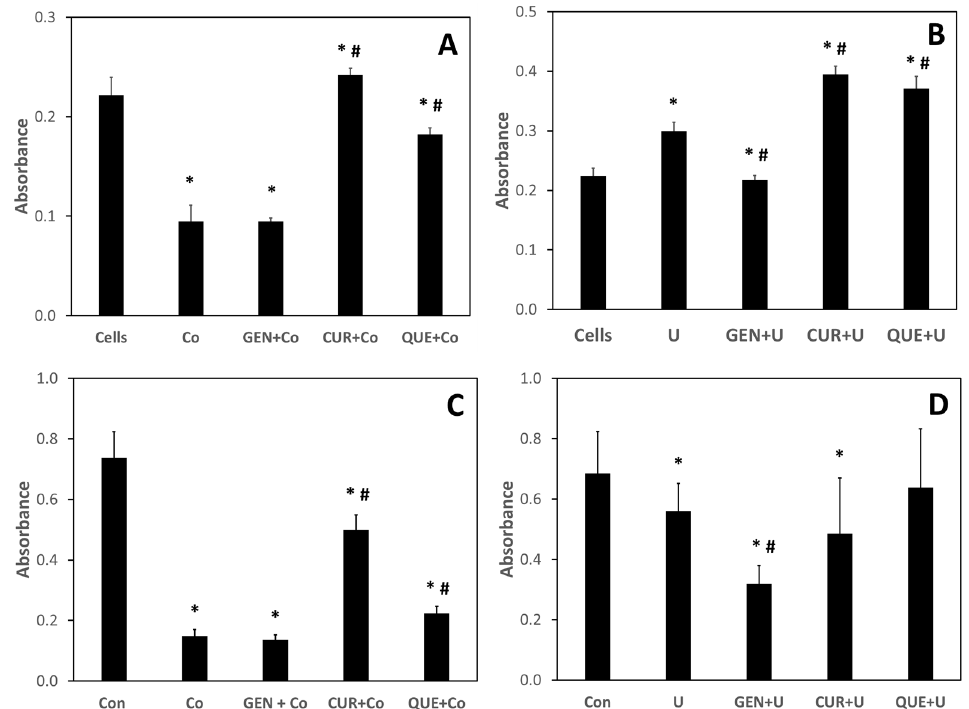
Figure 6. The ability of nutraceutical treatment to rescue cells from metal-induced metabolic toxicity. Effect of nutraceutical exposure on metabolic viability of J774 and Caco-2 cells. Cells were treated with cobalt (Co) or uranium (U) at 100 µM for 1 h followed by the addition, at 100 µM final concentration, of genistein (GEN), curcumin (CUR), or quercetin (QUE). After a 24 h incubation, metabolic viability was assessed using the MTT assay: ( A , B ) J774 cells treated with cobalt or uranium, respectively; ( C , D ) Caco-2 cells treated with cobalt or uranium, respectively. Data are the mean of three independent experiments. Error bars represent standard deviation. An * denotes a result statistically different from control and a # represents a statistically significant difference from the metal-treated cells, as determined by unpaired t-test with significance at p < 0.05. Table 2. Metal uptake by J774 cells in the absence and presence of